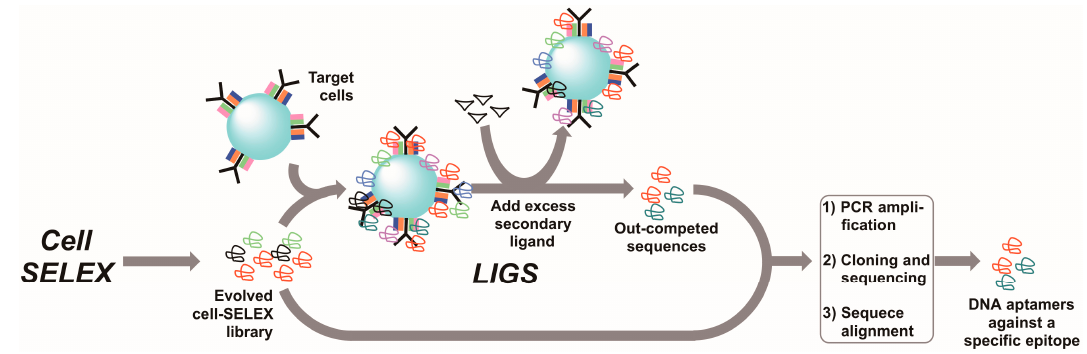
Figure 4. Schematic of ligand-guided selection. This approach effectively utilizes secondary ligands to selectively elute specific aptamers against a known surface marker. selectively elute specific aptamers against a known surface